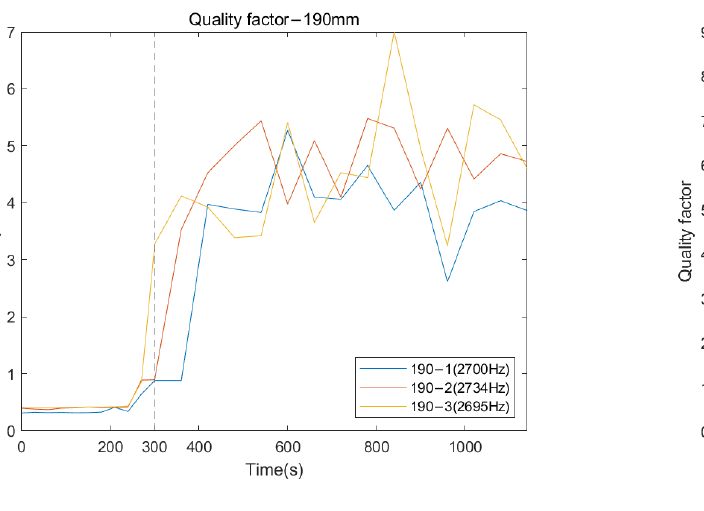
Figure 9. Cross-spectrum of normalised magnitude at 0, 150, 300, 600, and 1140 s cure times for residual lengths of ( a ) 190 and ( b ) 228 mm.